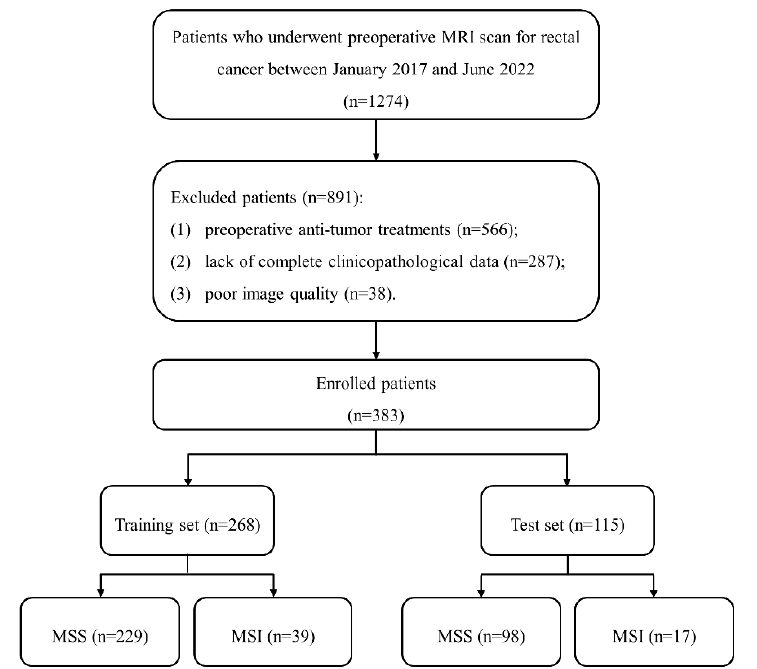
Figure 1. The patient recruitment process. (Note. MSS, microsatellite stability; MSI, microsatellite instability.)